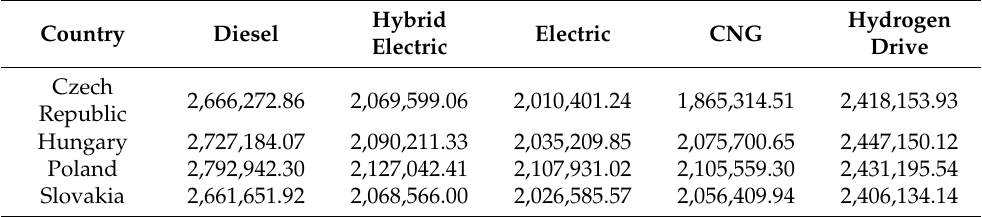
Table 10. The total cost of ownership of maxi (18 m) buses with different drive types in the V4 countries ( €